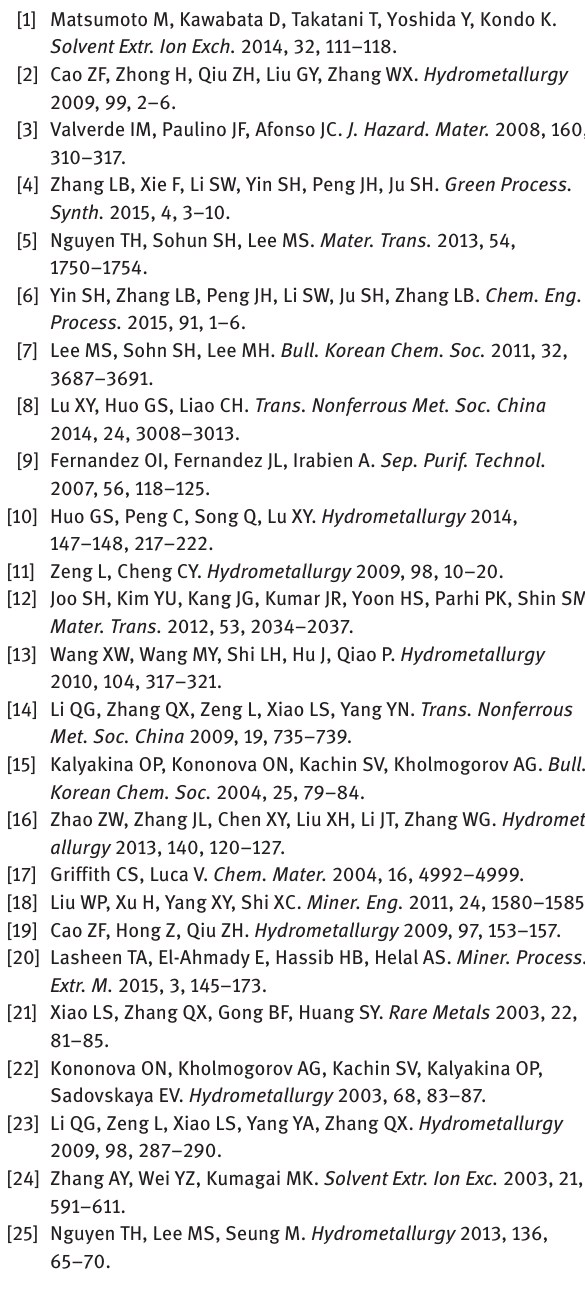
Table 3: Main compositions of molybdenum oxide products (wt.%). Compositions Mo S Molybdenum oxide products